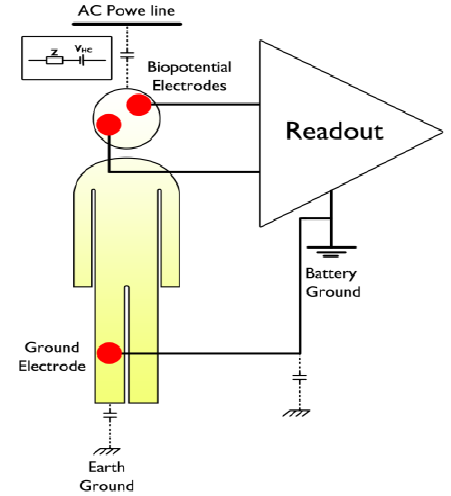
Figure 6. A biopotential readout circuit linked to the biopotential electrodes to extract the electroencephalogram